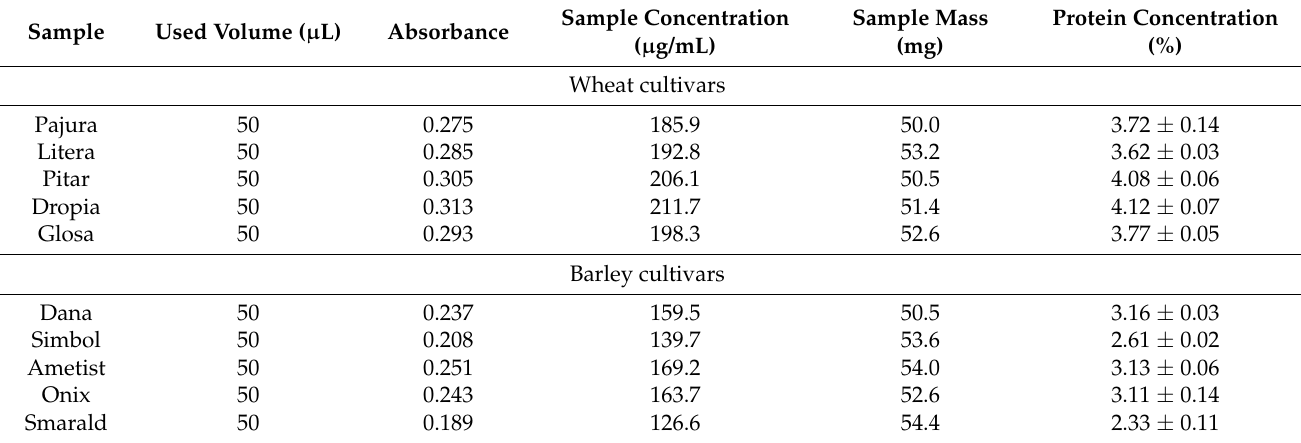
Table 4. Measured contents of the extracted proteins concentration in tris-glycine buffer (means values ± standard deviation).